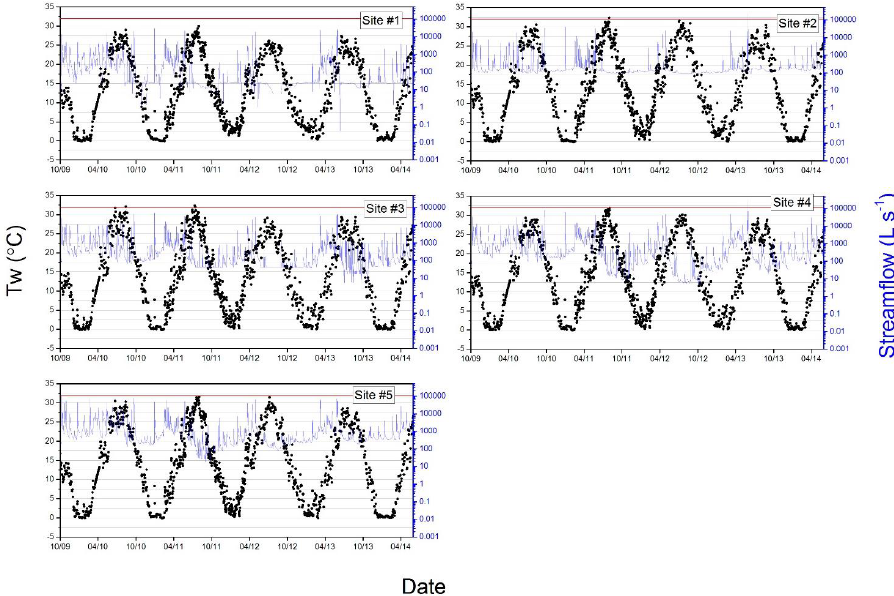
Figure 3. Stream water temperature (Tw) (°C) and streamflow (L s −1 ) at each gauging site ( n = 5) during study period (October 2010–May 2014) in Hinkson Creek Watershed, MO, USA. Red lines depict